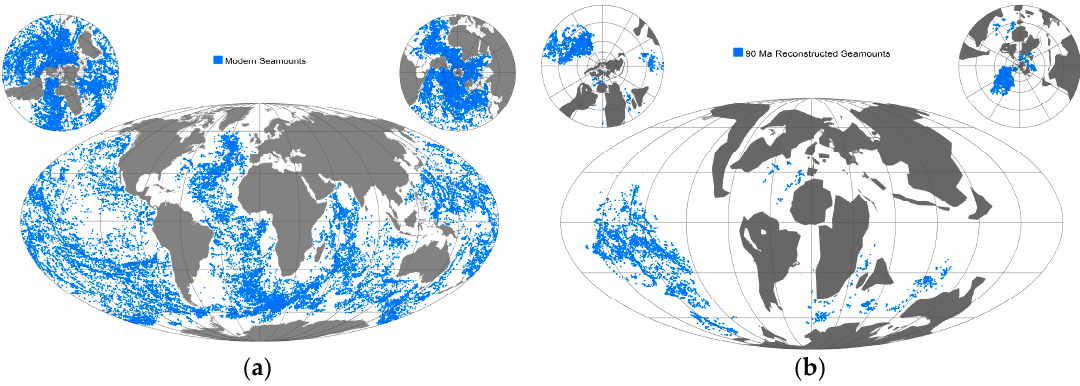
Figure 3. Distribution of seamounts in the ocean basins. ( a ) Modern; ( b ) 94 Ma.